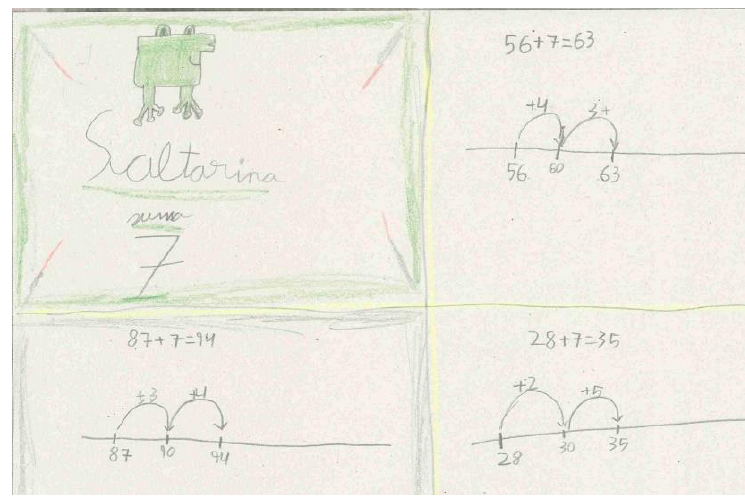
Figure 31. Saltarina’s worksheet: it adds seven.